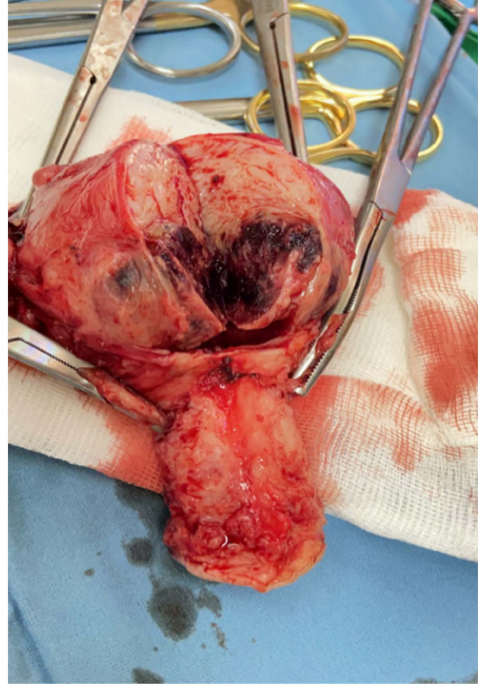
Figure 5. Placenta percreta with abnormal vascularization reaching the lower uterine segment.